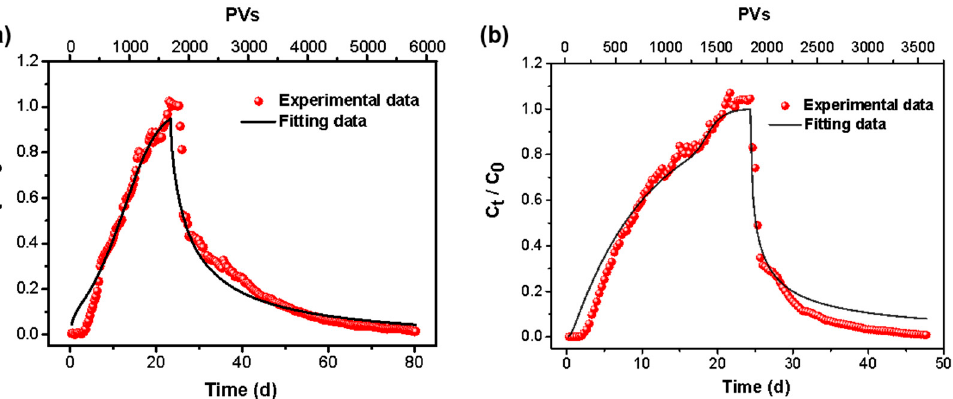
Figure 7. The breakthrough curve of Cr (VI) in different concentrations ( a ) 5 mg/L and ( b ) 20 mg/L for a column packed with hematite. Table 2. Parameter values obtained from HYDRUS-1D for Cr (VI) transport through columns packed with hematite in different